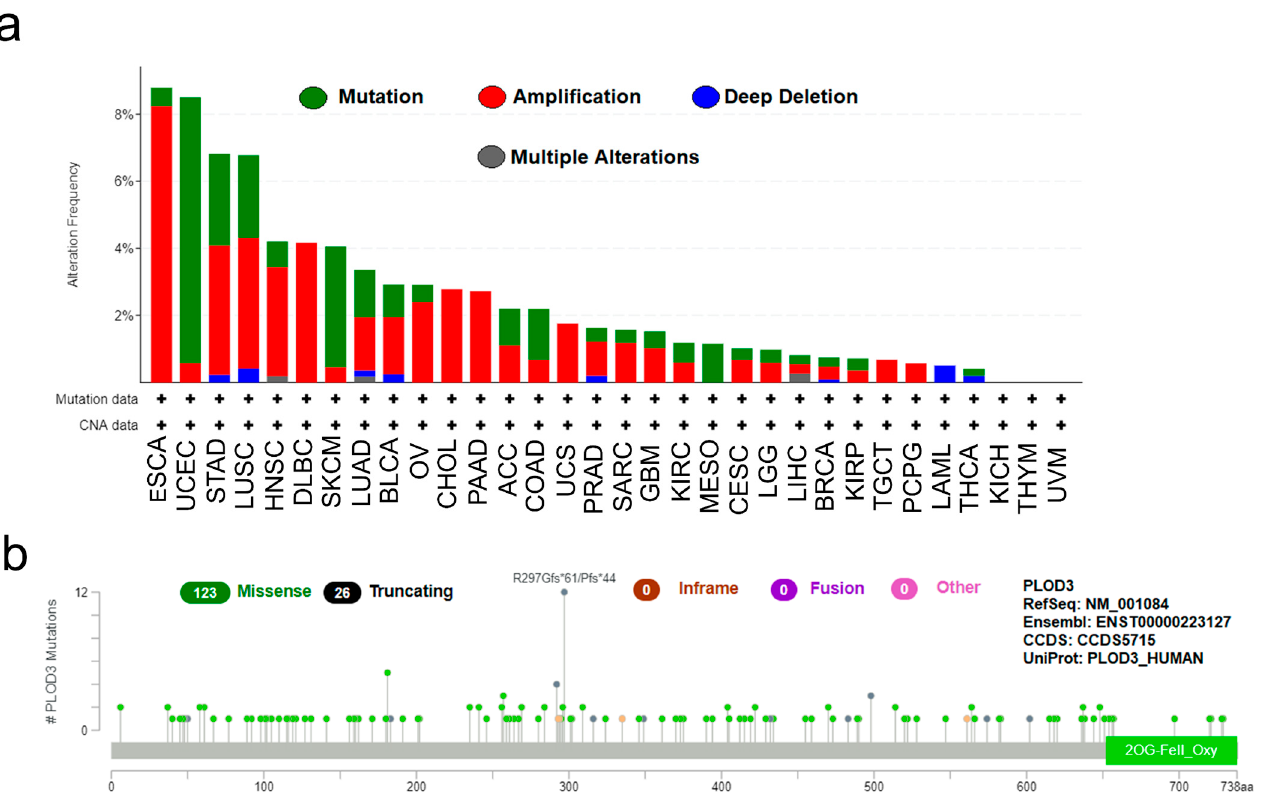
Figure 2. PLOD3 mutation feature in different tumors of TCGA. The alteration frequency and the type is shown in ( a ). The mutation types, sites and frequency of PLOD3 genetic alteration are displayed in ( b ).